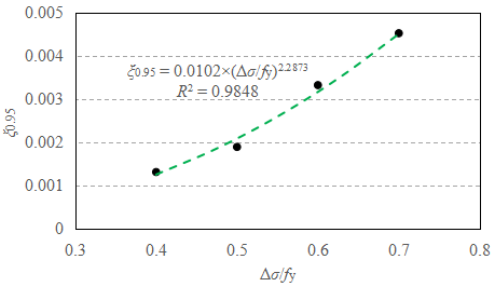
Figure 8. Fitting function of the parameter ξ 0.95 and the relative stress amplitude, Δ σ / f